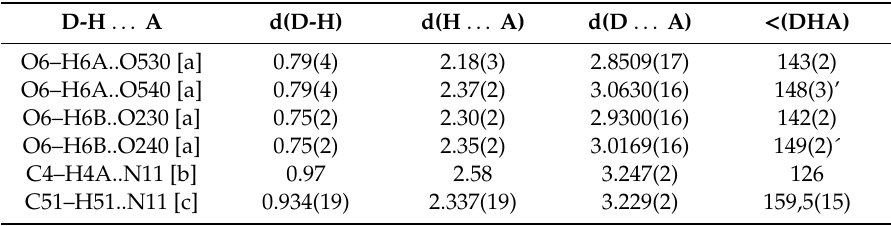
Table 5. Hydrogen bond scheme (distances and angles) for 1